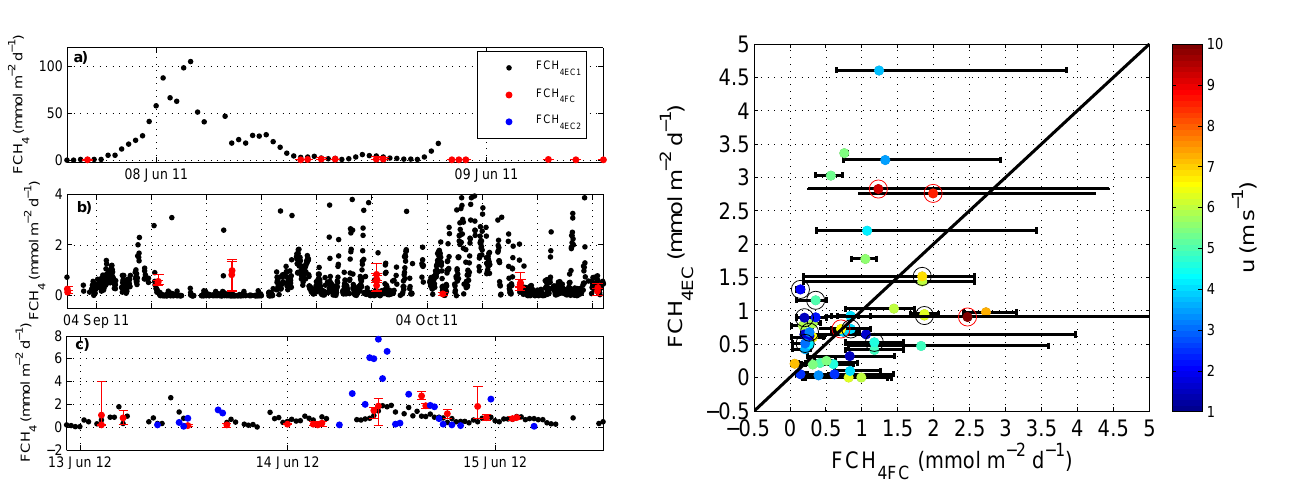
Figure 3. FCH 4FC , i.e. mean values of 4–6 FCs deployed in the flux footprint compared to mean values of FCH 4EC during the same time. The bars represent the maximum and minimum FC measure- ment during one deployment. The colours in the figure show the mean wind speed during the FC deployment period. Red circles enclosing filled circles represent the four comparisons of EC2 and FC. Black circles enclosing filled circles mark FCs with deployment times longer than 30 min in the EC1 footprint. The black line shows a 1 : 1 relation. The total number of direct comparisons n =